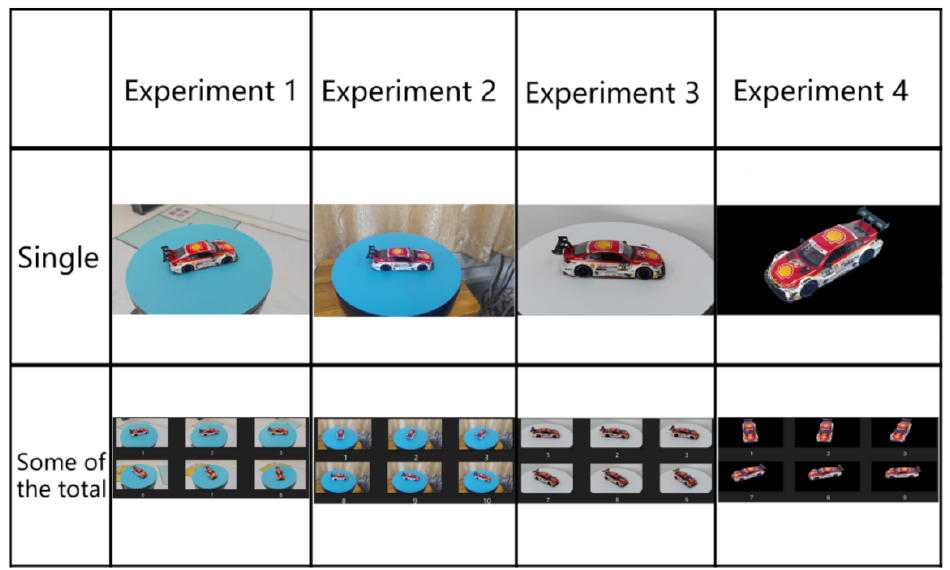
Figure 14. The dataset organization.